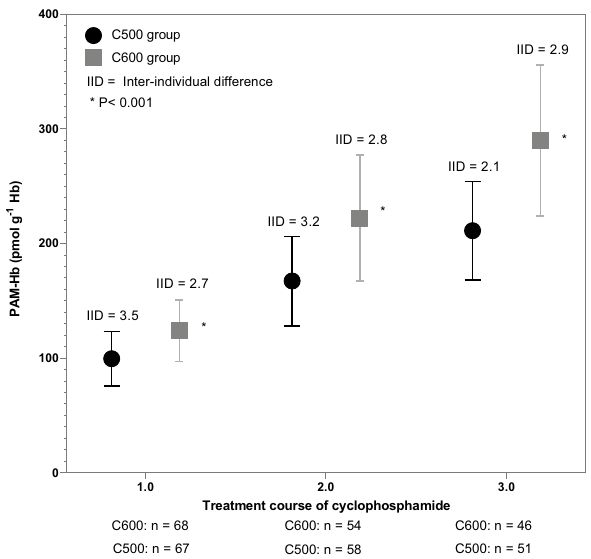
Figure 2. Mean (± standard deviation) levels of phosphoramide mustard-hemoglobin (PAM-Hb) for patients receiving 500 mg (C500 group) or 600 mg (C600 group) cyclophosphamide per body surface area unit during three treatment courses and the inter-individual difference per course. Difference between mean PAM-Hb levels between C500 and C600 groups was compared with an independent sample t-test. Patients were included until they changed cyclophosphamide dose or stopped the